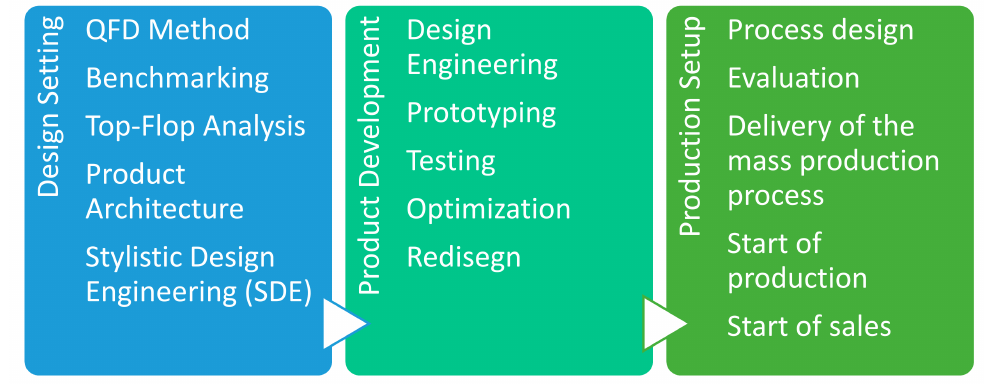
Figure 3. Industrial Design Structure